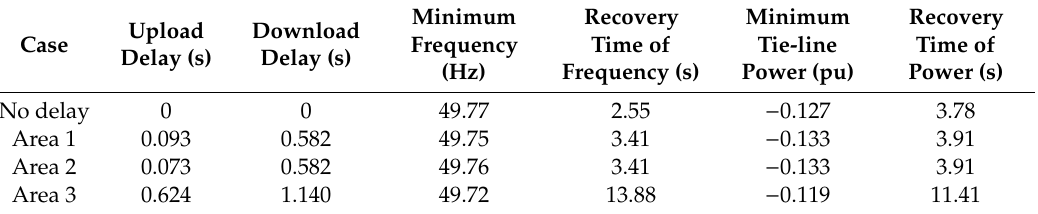
Figure 13. The frequency and power response with load frequency control (LFC) strategy under various delays. ( a ) Frequency response; ( b ) tie-line power response. Table 3. Simulation results with LFC